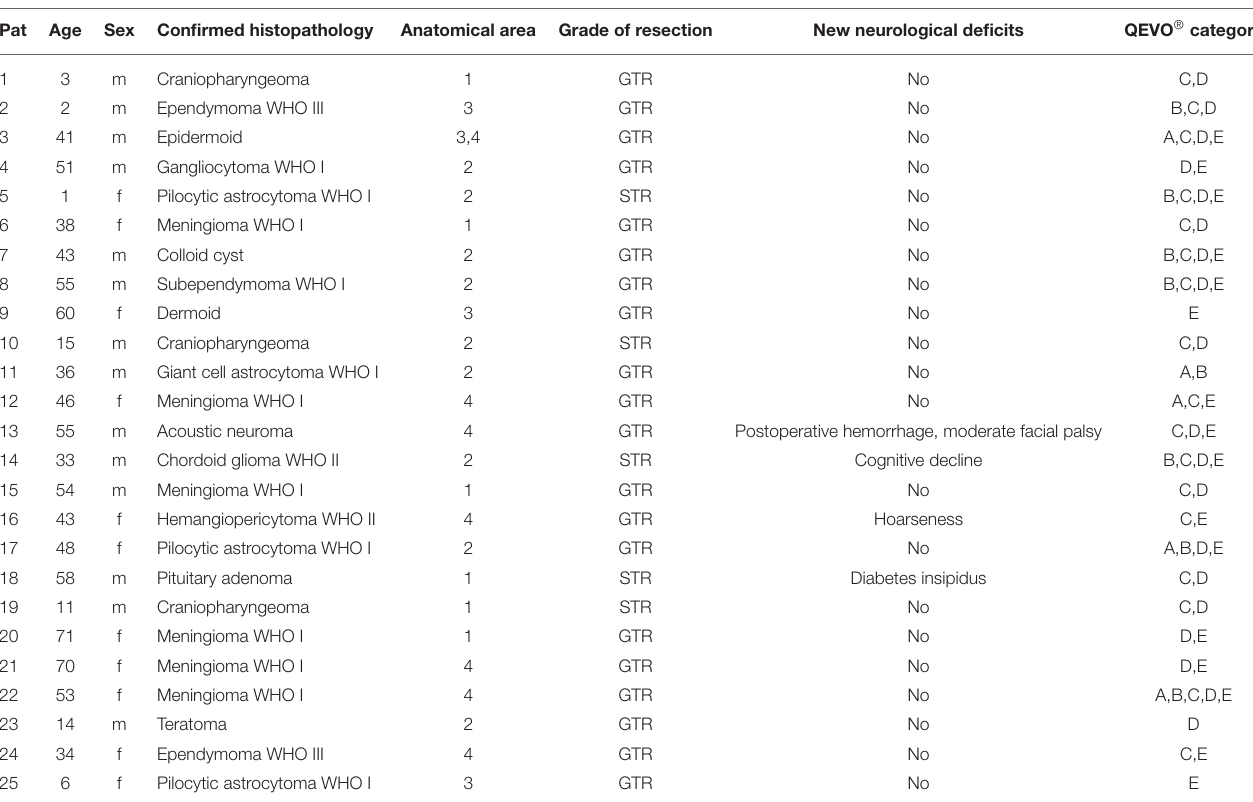
TABLE 1 | Overview and baseline data of patients. Pat Age Sex Confirmed